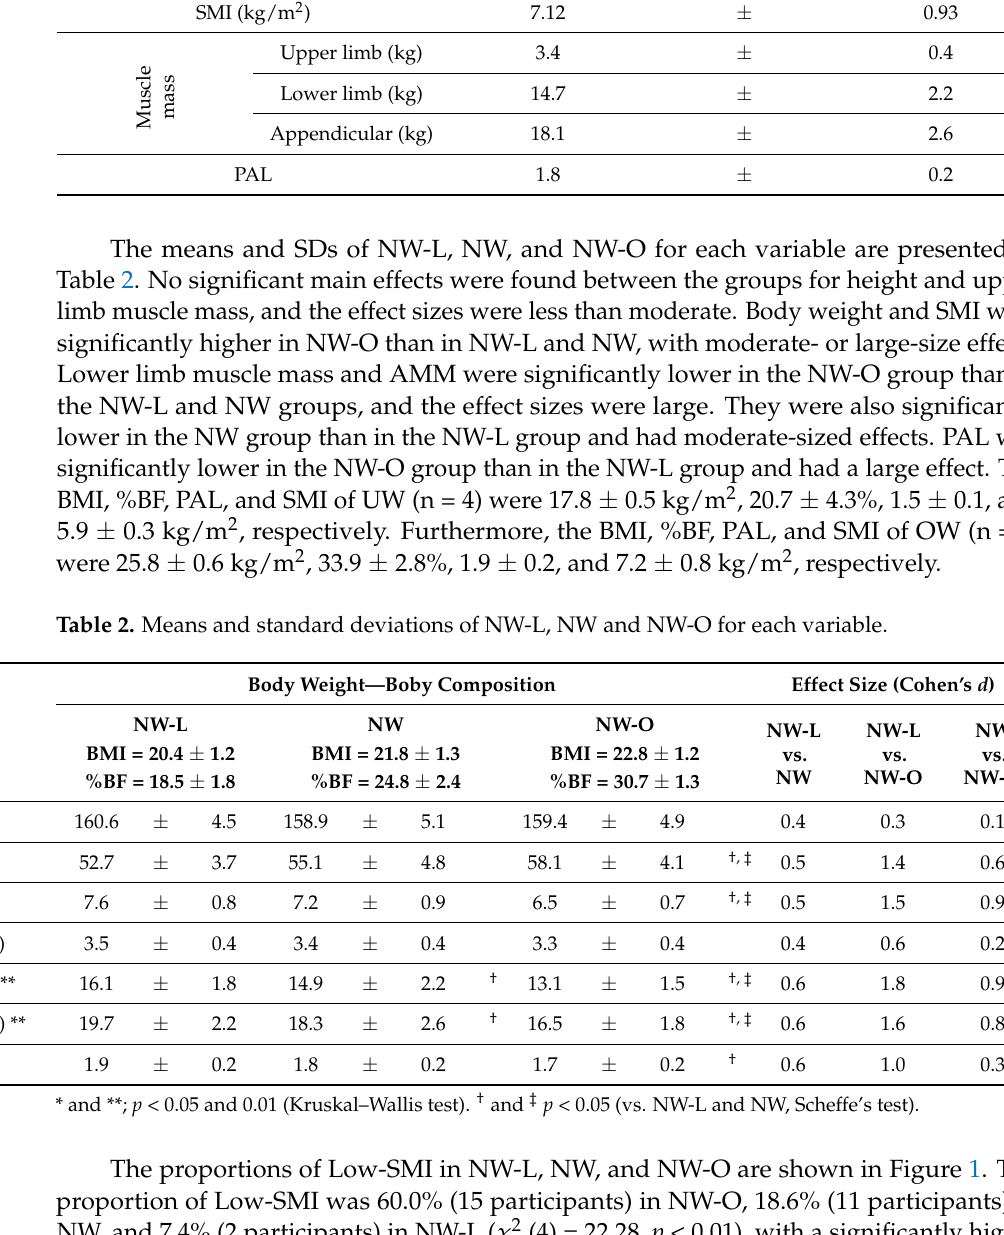
The proportions of Low-SMI in NW-L, NW, and NW-O are shown in Figure 1.